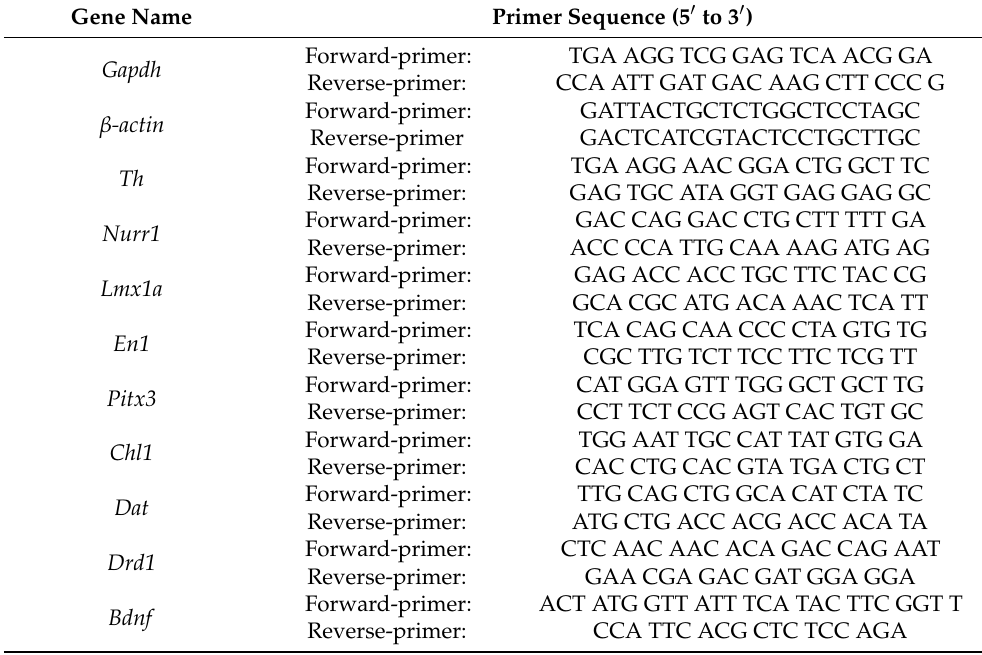
Table 1. Gene-specific primer pair sequences used in the